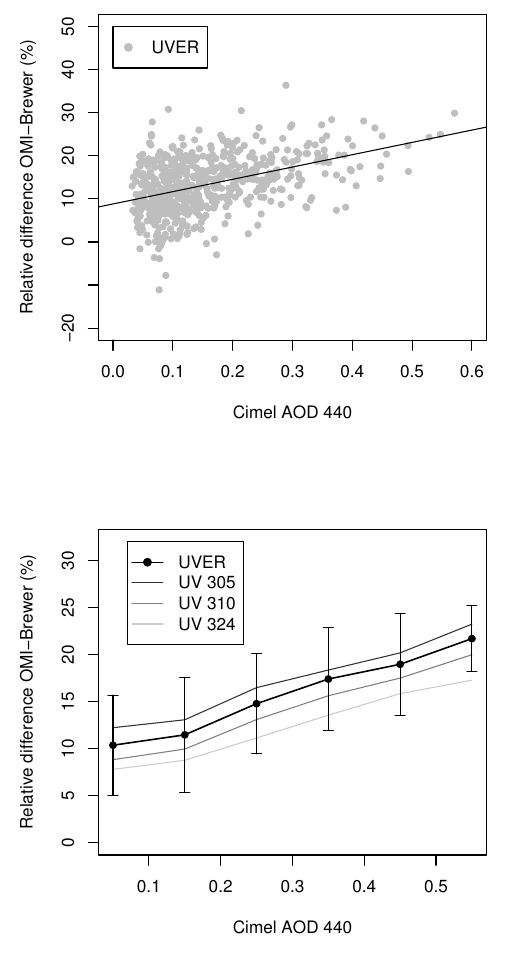
Fig. 3. Top) Dependence of the relative difference between OMI and Brewer UVER data with respect to the aerosol optical depth (AOD) at 440nm measured from the Cimel photometer at El Arenosillo station for cloud-free conditions (dataset #2). Bottom) the same as before but taking binned data for the four UV OMI products. The data are binned with a 0.1 AOD bins.